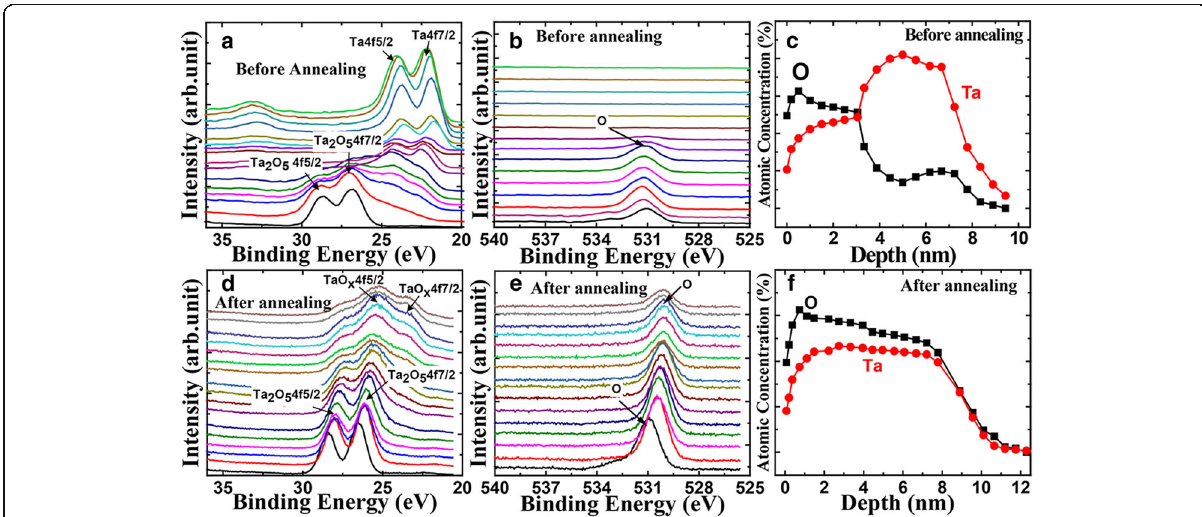
Fig. 1 The XPS shows depth profile of Ta before ( a ) and after ( d ) annealing. b , e Depth profile of O before and after annealing, respectively. c, f Atomic concentration profile of O and Ta with depth before and after annealing,